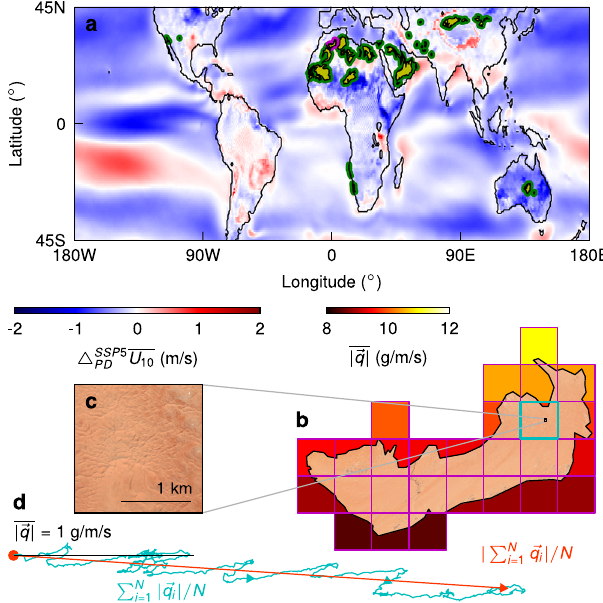
Fig. 1 Sand-sea locations and fl ux extraction example. a 45 sand seas (yellow, with thick border for clarity; green except for purple example in ( b )) analysed in this study on an ensemble-average map of the annual- average 10-m wind speed anomaly from present-day (decade ending 2014) to the predicted SSP5-8.5 decade ending 2100, Δ SSP 5 PD U 10 (m/s). b A LANDSAT image of an example sand sea, the Grand Erg Occidental, northern Algeria, overlaying the nominally 100-km ESM grid (purple) showing the ensemble-average present-day annual sand fl ux magnitude j q ! j (g/m/s). c A MAXAR image of dune morphology in the cyan tile. ( d ) An example sand fl ux trajectory (cyan) for one ensemble member of the cyan tile in ( b ) for the 2005-2014 decade with a scale j q ! j ¼ 1 g/m/s (black line); the length of the orange and cyan lines give the resultant ! j = N and total ∑ N ! j = N sand fl ux magnitudes, respectively, q q j ∑ N i i i i ¼ 1 j ¼ 1 where N is the number of fi ltered spatially by using sand-sea masks manually extracted from LANDSAT imagery and weighting the grid tiles according to their coverage of the sand sea 1 (Methods), allowing us to fi nd the average sand fl ux for each sand sea (Methods). Then a global time series for each ensemble member in a scenario is found as the sand-sea area- weighted average sand fl ux. We plot the mean global average sand fl ux time series smoothed over a 5-year window shadowed by the ensemble standard deviation for each scenario (Fig. 2a). A clear and signi fi cant trend of a future global decrease in sand fl ux in the sand seas emerges from the forcing variability in time (noise in the